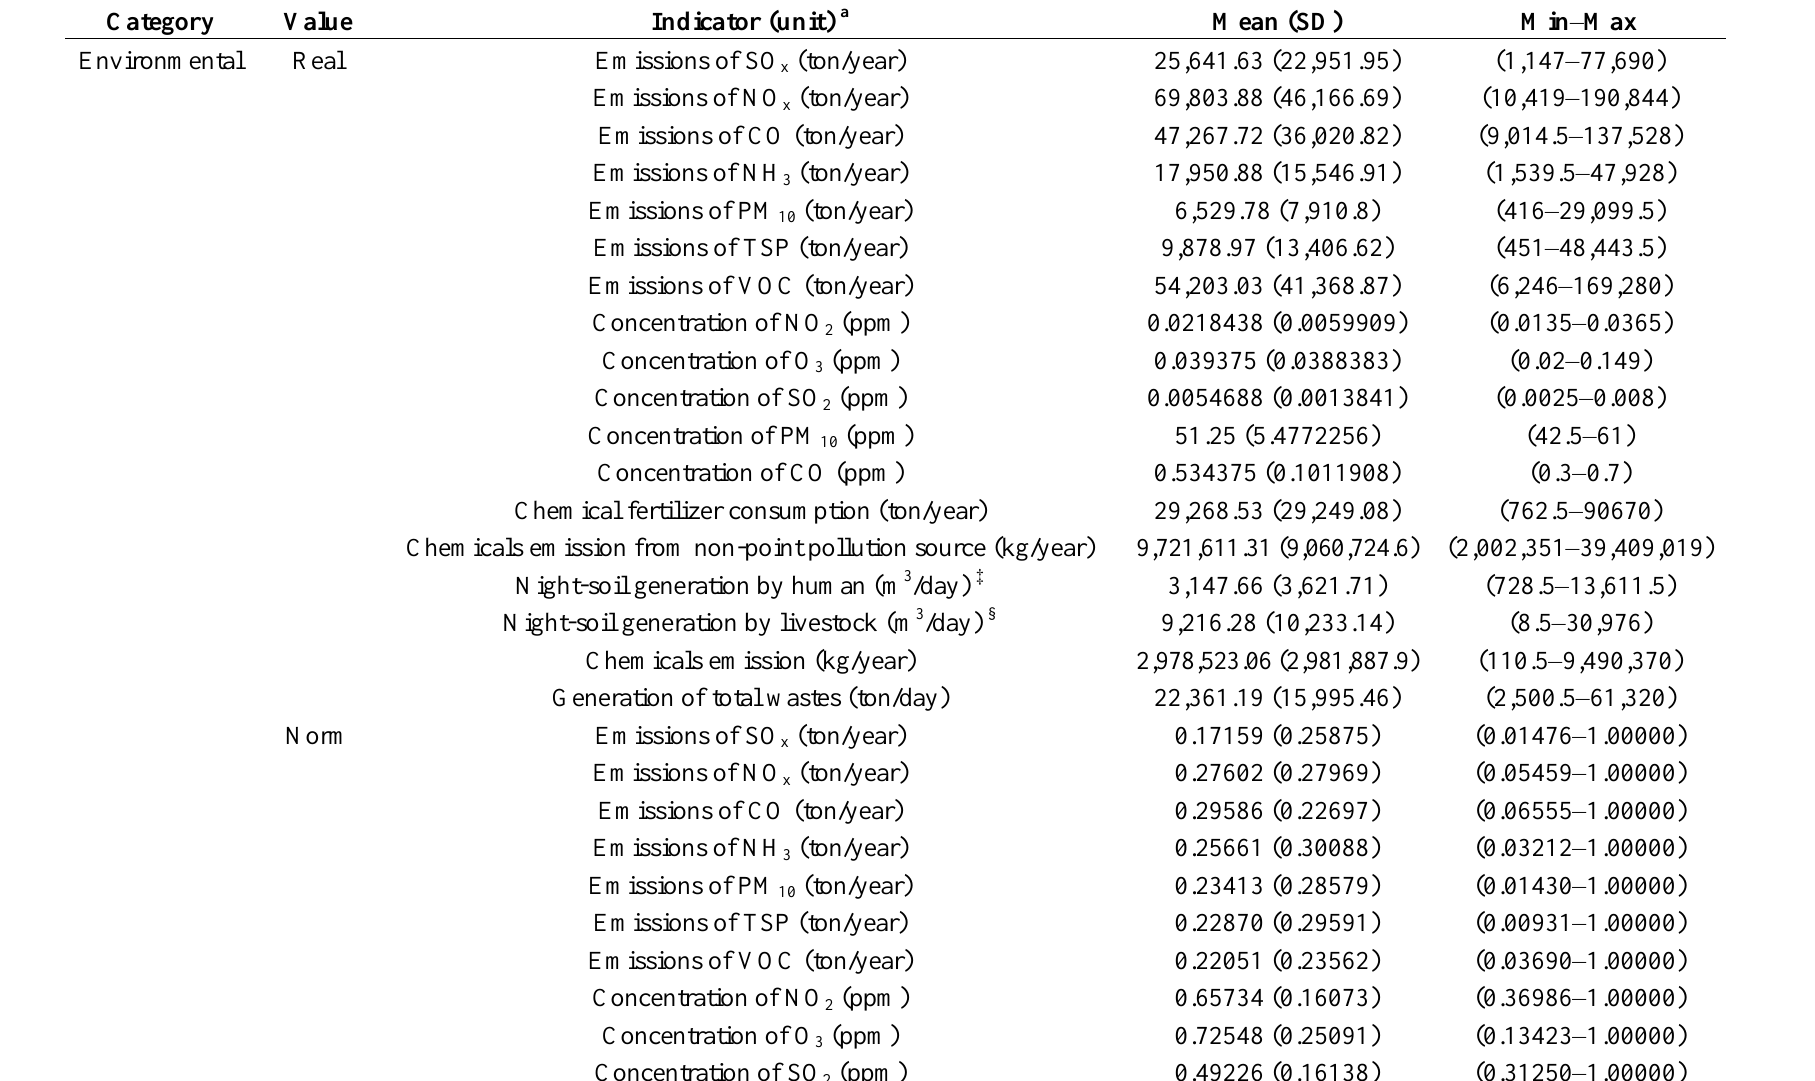
Table 2. Descriptive table of the real, normalized, and synthesized values of indicators